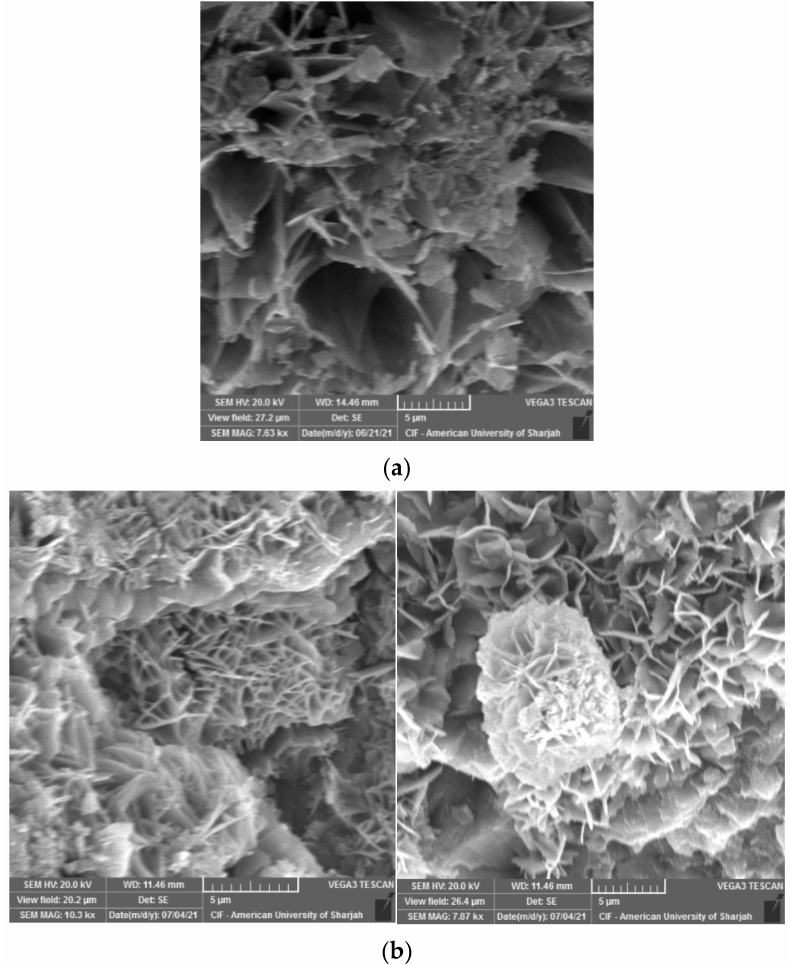
Figure 11. Iron oxide products for the GB15FA15 mix. ( a ) early age HAC; ( b ) late age WC.